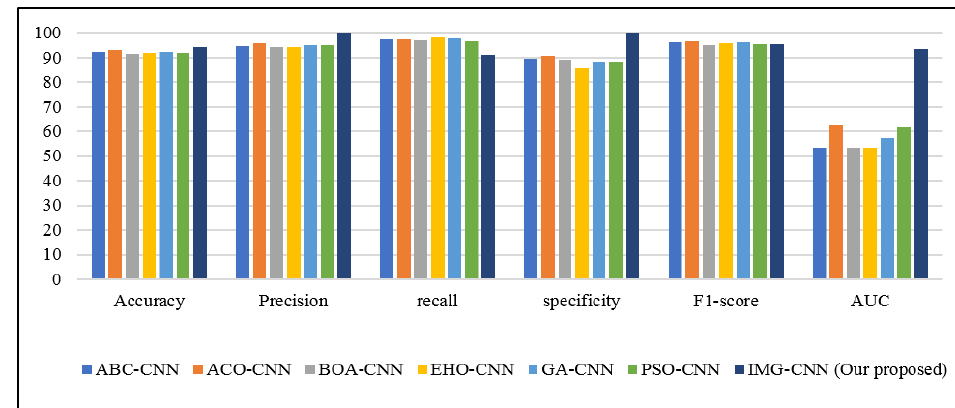
Figure 16. Comparison of the performance evaluation metrics of the different models presented in previous studies and our proposed IMG-CNN model using deep learning models.